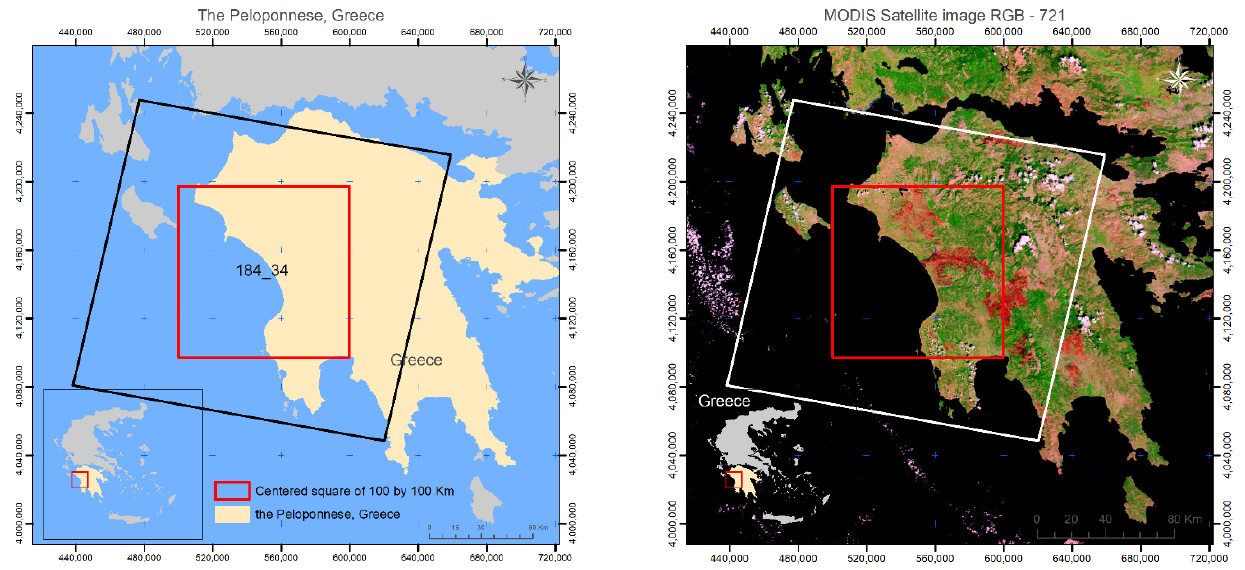
Figure 2. The study area was the Peloponnese, Greece (left), which experienced large wildland fires in 2007 that have been recognized as the most extreme natural disaster in the country’s recent history [41], as seen in the MODIS image (“NASA/GSFC, MODIS Rapid Response”) (right). The box in red is the square of 100 × 100 km centered in each Landsat scene used to reconstruct the recent fire history. The coordinate system is the Greek Grid (EGSA87).